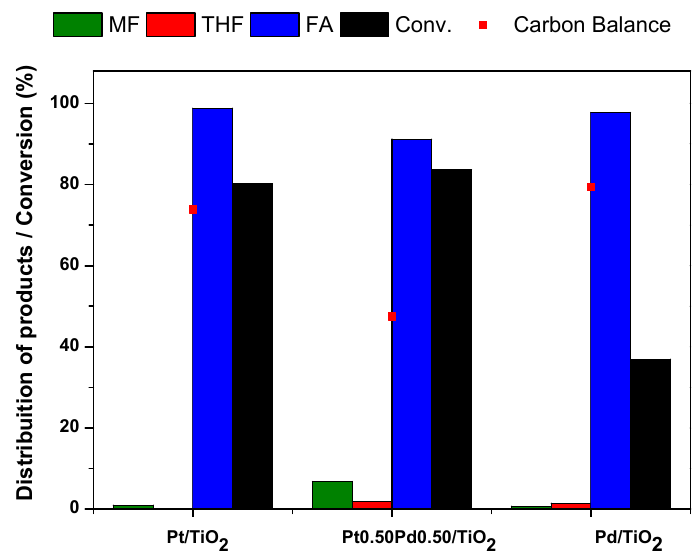
Figure 7. Furfural hydrogenation. Conditions: 2 mL of solution of furfural in isopropanol, 2 h, mass of